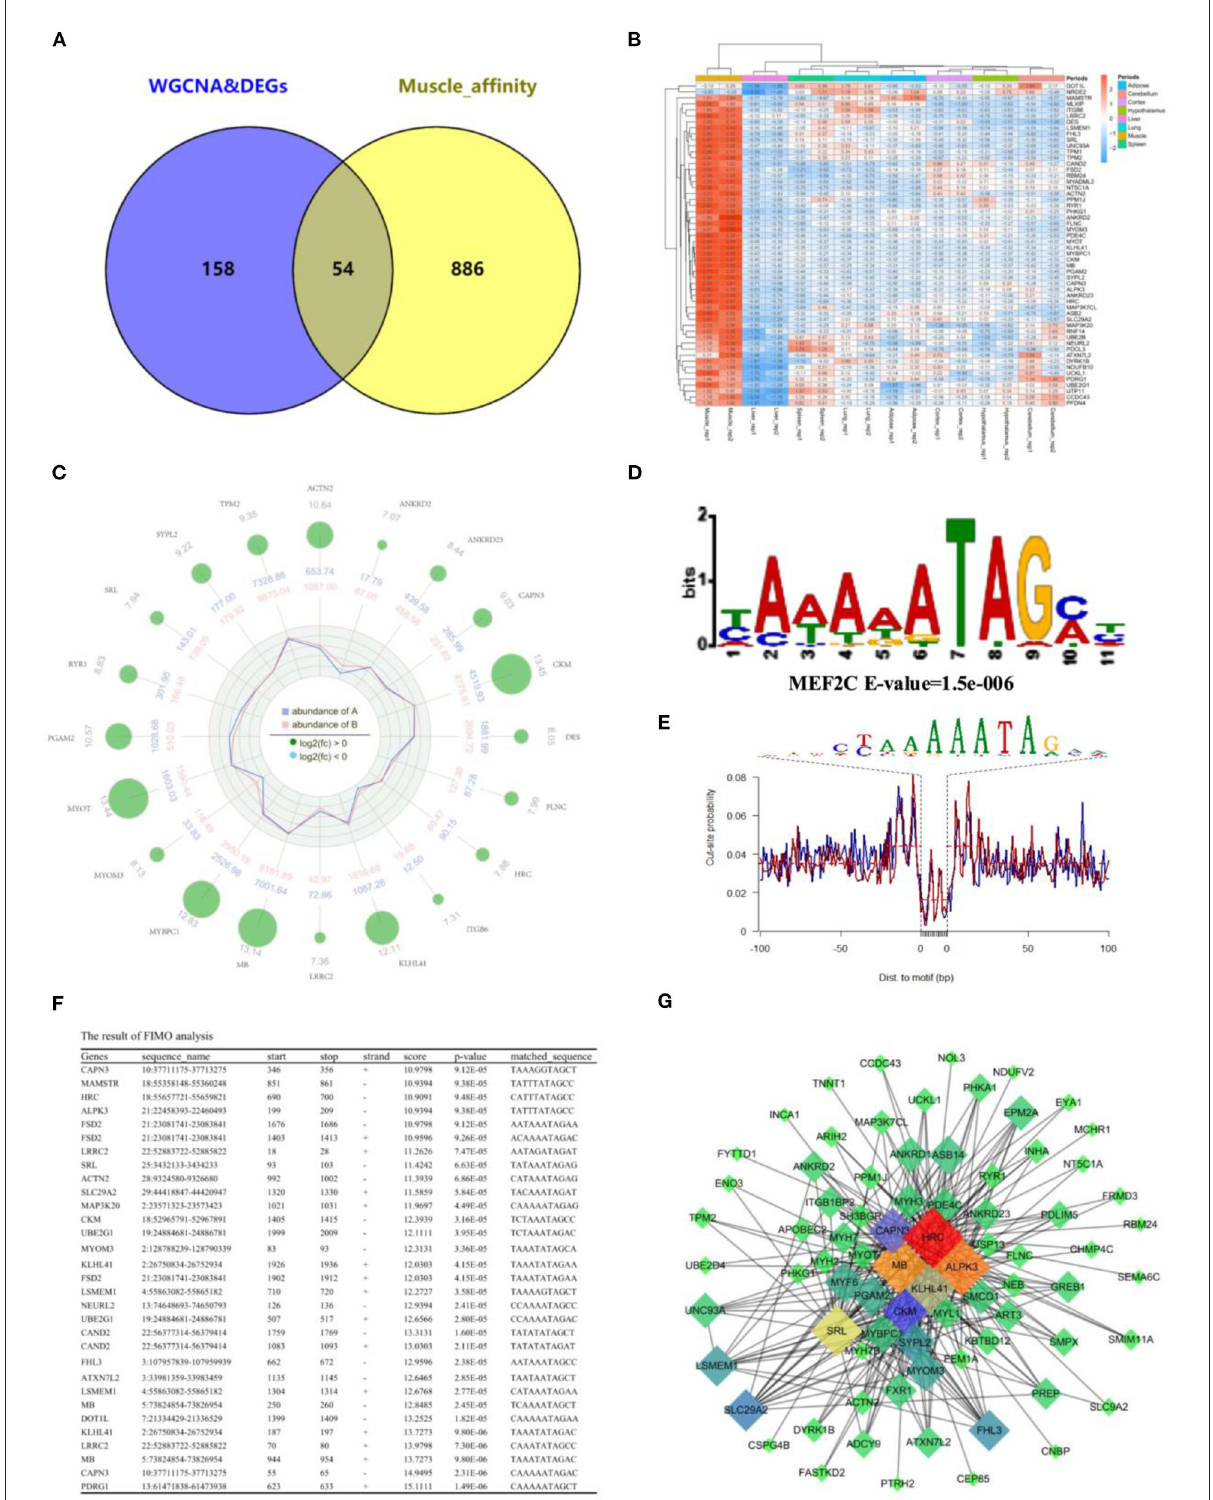
FIGURE7 Integration of RNA-Seq and ATAC-Seq. (A) Venn plot of ATAC-seq and RNA-seq, and 54 common genes were found; (B) Heatmap plot of common genes; (C) Radar plot of the top 20 common genes; (D) Motif enrichment analysis of common genes around open chromatin regions. MEF2C was found to be significantly enriched; (E) The motif footprint analysis of MEF2C; (F) Motif Scanning of MEF2C in promoter region of common gene using FIMO; (G) The subregulatory network of 22 predicted MEF2C potential target genes in the ME light module was derived from WGCNA